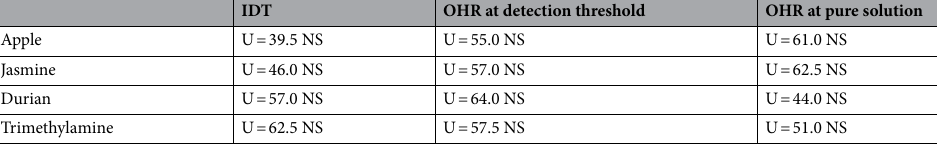
Table 5. Mann–Whitney U tests: sex effect on IDT, OHR at detection threshold and at pure solution for all odors used. Non-significant results are noted as NS.